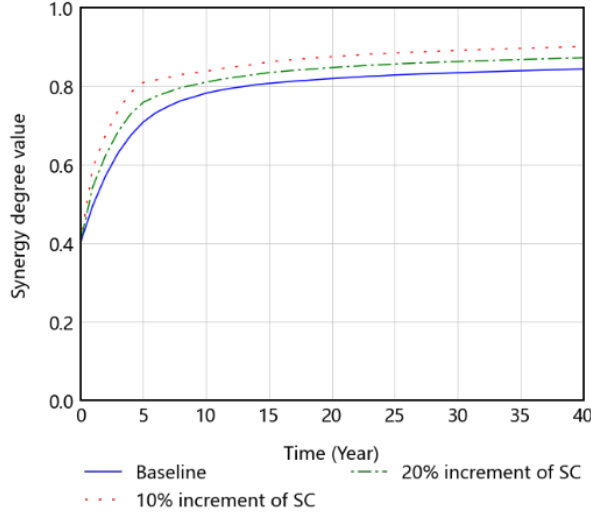
Figure 13. The effects of different degrees of SC on synergy.